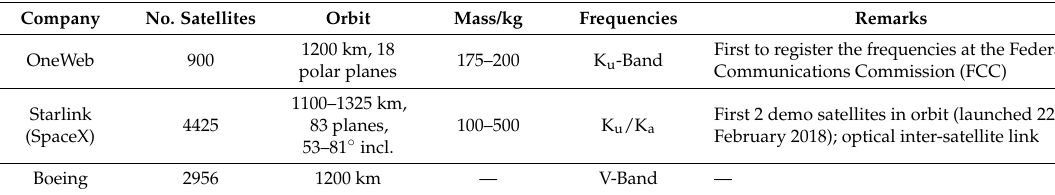
Table 1. Selection of recently proposed large satellite constellations; based on